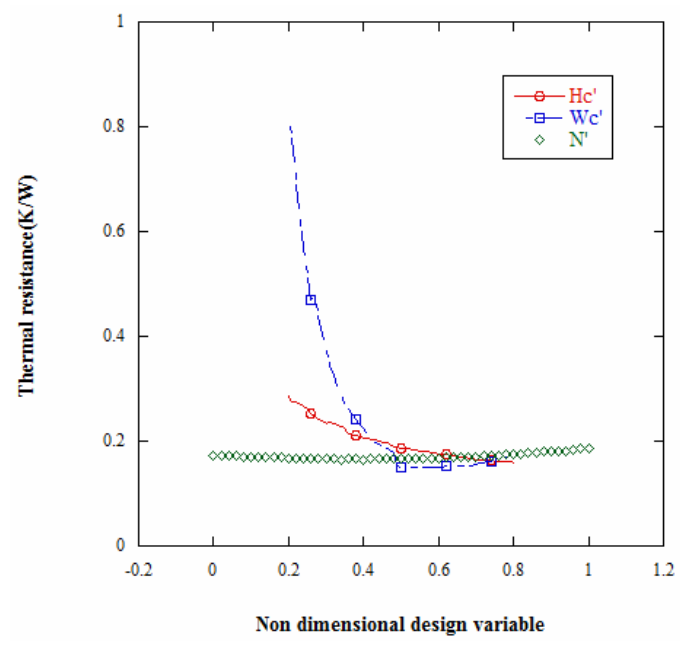
Figure 5. Sensitivity analyses of the non ‐ dimensional design variables for the micro channel heat sink.